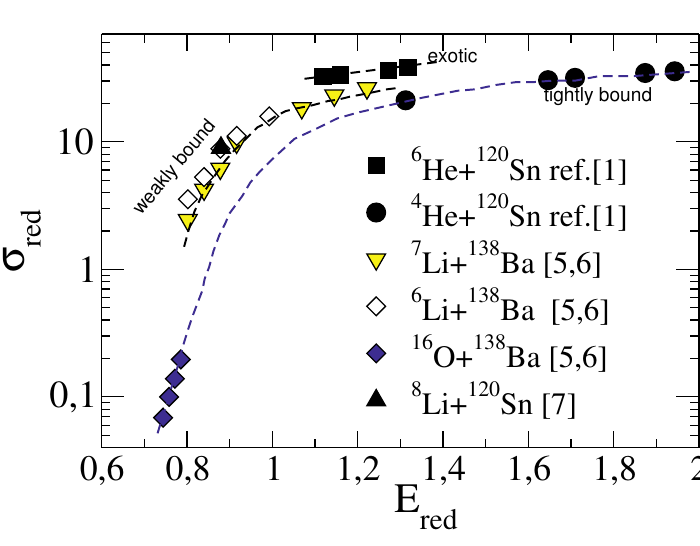
Figure 2. Reduced reaction cross sections from ref. [1]. Table 1. Reduced total reaction cross sections for the 6 He + 120 Sn [1] system obtained from Optical Model and CDCC calculations compared with fusion cross sections. (see text for more details) E lab